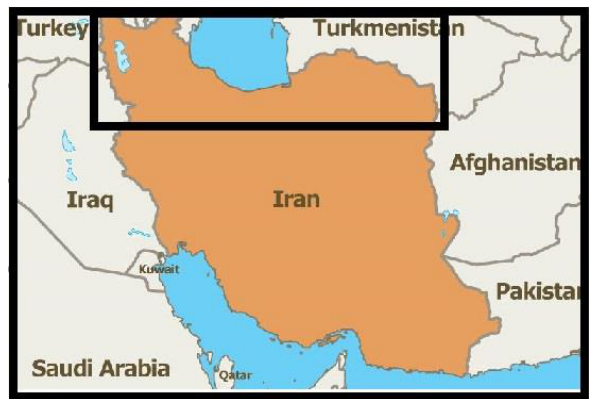
Figure 1. Location of Caspian (Khazar)